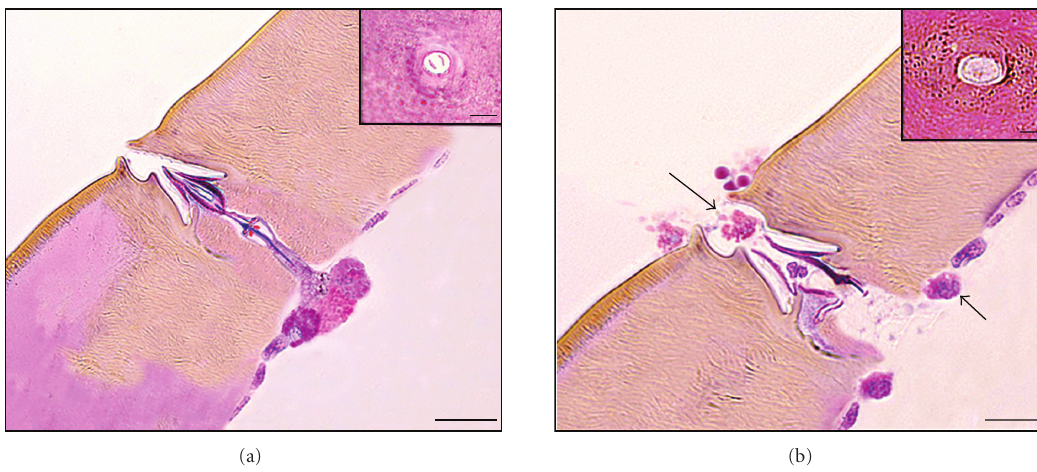
Figure 2: Micrographs of sagittal sections of large wax glands (sensilla sagittiformia = arrow-organs) in nonfed adult females of R. sanguineus . (a) Intact large wax gland showing regular microscopic anatomy (corresponding drawing in Figure 1 with parts labeled that match Schulze’s [2] description). The gland has a restricted pore opening (inset, direct view), a thick spongy chitinous layer, and three large glandular cells occupying most of the proximal terminal chamber lumen. Bar = 30 µ m, and Bar = 10 µ m (inset). (b) Evacuated large wax gland of ticks that had been stimulated to secrete. Most of the morphology of the large wax gland has been destroyed. Glandular cells have been forced up into the tuft chamber and distal duct, and as they existed under high pressure these cells have been broken into pieces (long arrow). The glandular cell pieces have forced open the pore and widened its diameter and the spongy elastic chitinous frame around the gland pore (inset). Note that juxtapositioned cells are hypertrophied and have started the di ff erentiation process to replace glandular cells that had been ejected during release of the secretion (short arrow). Similar morphology was observed in 20 replicates, and these two micrographs are representative of those replicates. Bar = 30 µ m, and Bar = 10 µ m